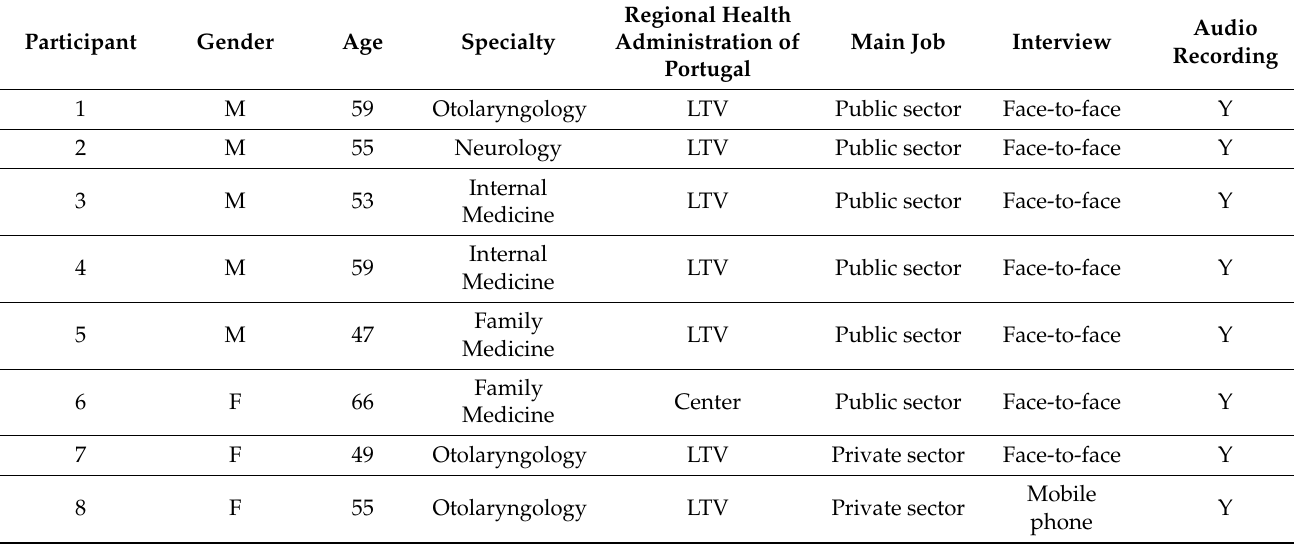
Table 4. Study qualitative: Socio-demographic data of the participants and interview features.